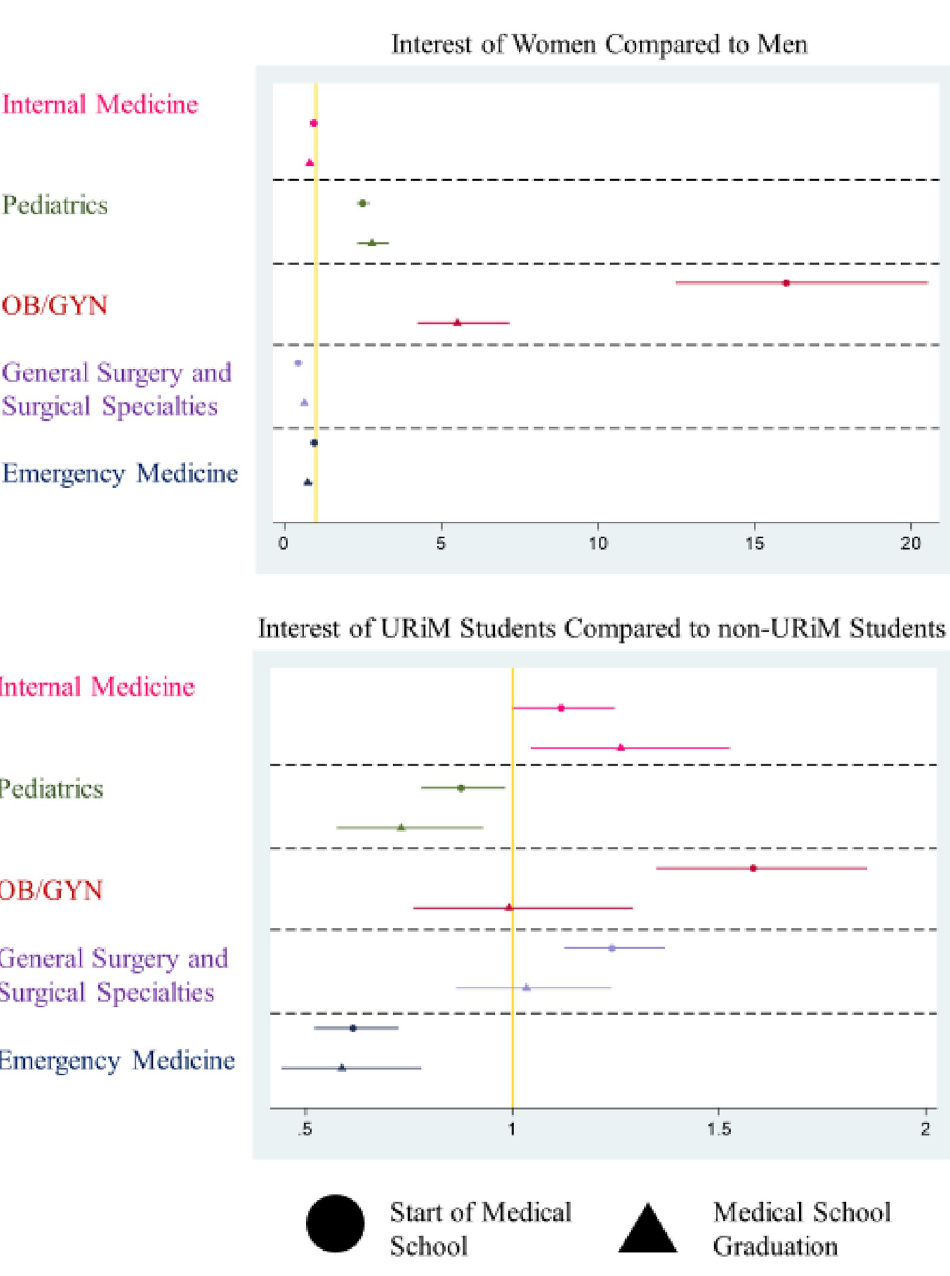
Fig 1. Career interest at onset and graduation. Plot of Odds Ratios from Two Outcomes (Specialty Interest at the Onset of Medical School and Specialty Interest at the time of Graduation) on a logarithmic scale. X-Axis represents the Odds Ratio of the Outcome in each model for each group. Gold line represents Odds of 1 (no effect). Y-Axis represents the medical specialties investigated. Each point represents the calculated Odds Ratio with the 95% Confidence Interval for each value represented by bars to either